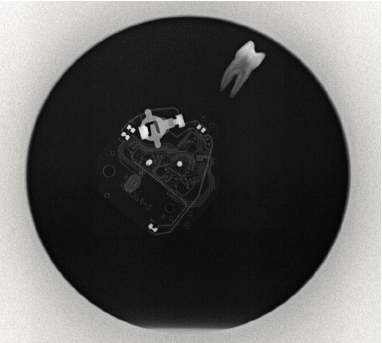
Figure 9. Photograph of the anode and cathode geometry in our X-ray tube; the anode material is Cu.